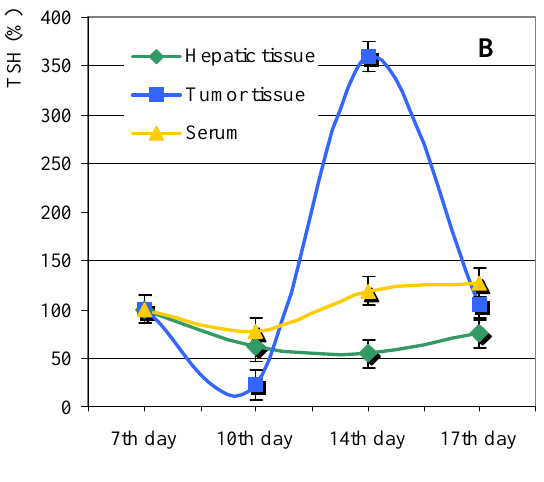
Figure 4. Effect of Lonicera caerulaea berry extracts on total thiol groups (TSH).